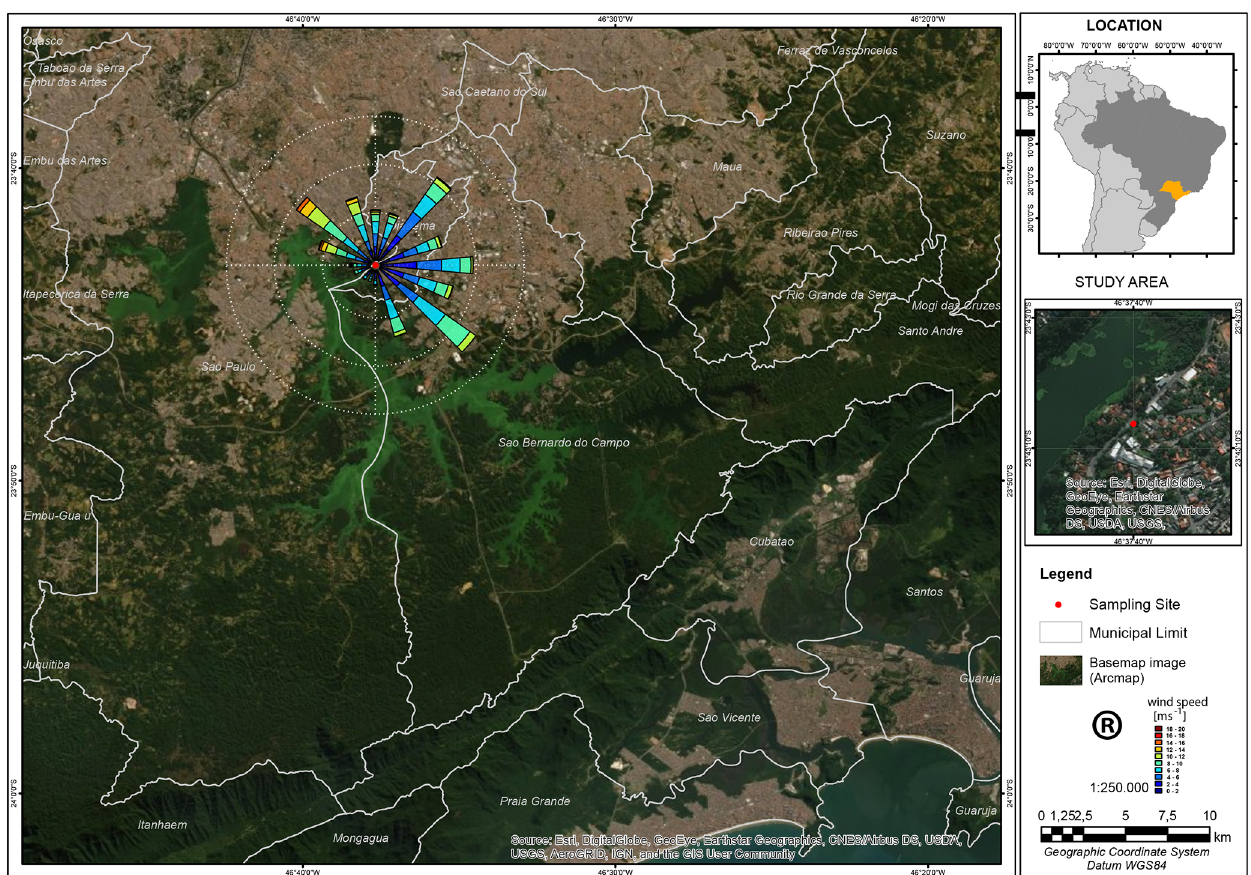
Figure 1. Map of Brazil indicating São Paulo state and showing a detailed view of the sampling site (red point), located in the southeastern part of the MASP in Diadema city. Source: Esri, DigitalGlobe, GeoEye, Earthstar Geographics, CNES/Airbus DS, USDA, USGS, AeroGRID, IGN, and the GIS User Community. Wind rose during the campaign was calculated from data from the Institute of Astronomy, Geophysics and Atmospheric Sciences of the University of São Paulo (IAG) meteorological